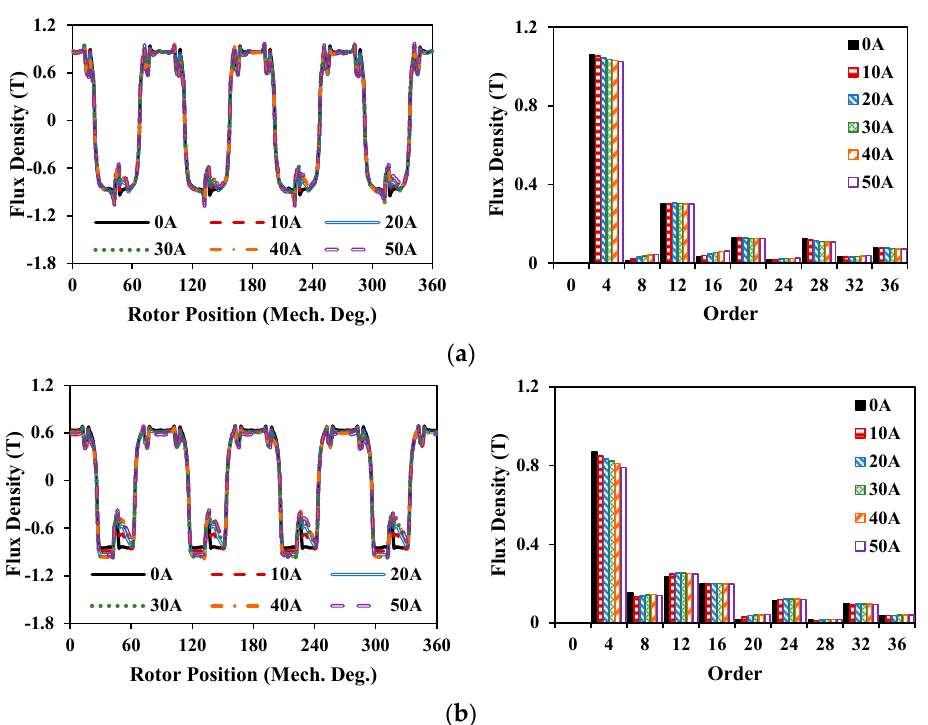
Figure 4. Air-gap flux densities and spectra for 12s8p machines. ( a ) 12s8p-SPM. ( b ) 12s8p-CCPPM.